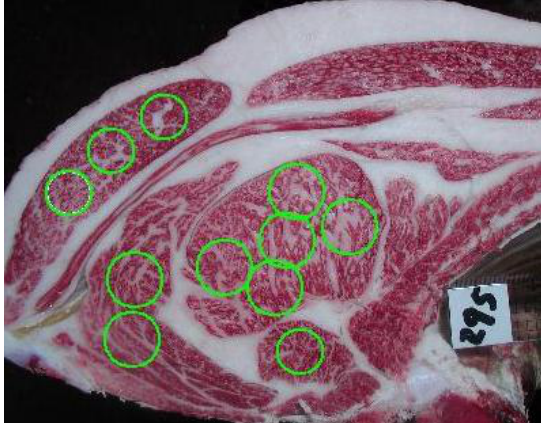
Figure 1. Overall trace method by image analysis. Muscle areas were surrounded by the boundary line which was drawn with automatic and manual traces by image analysis software.